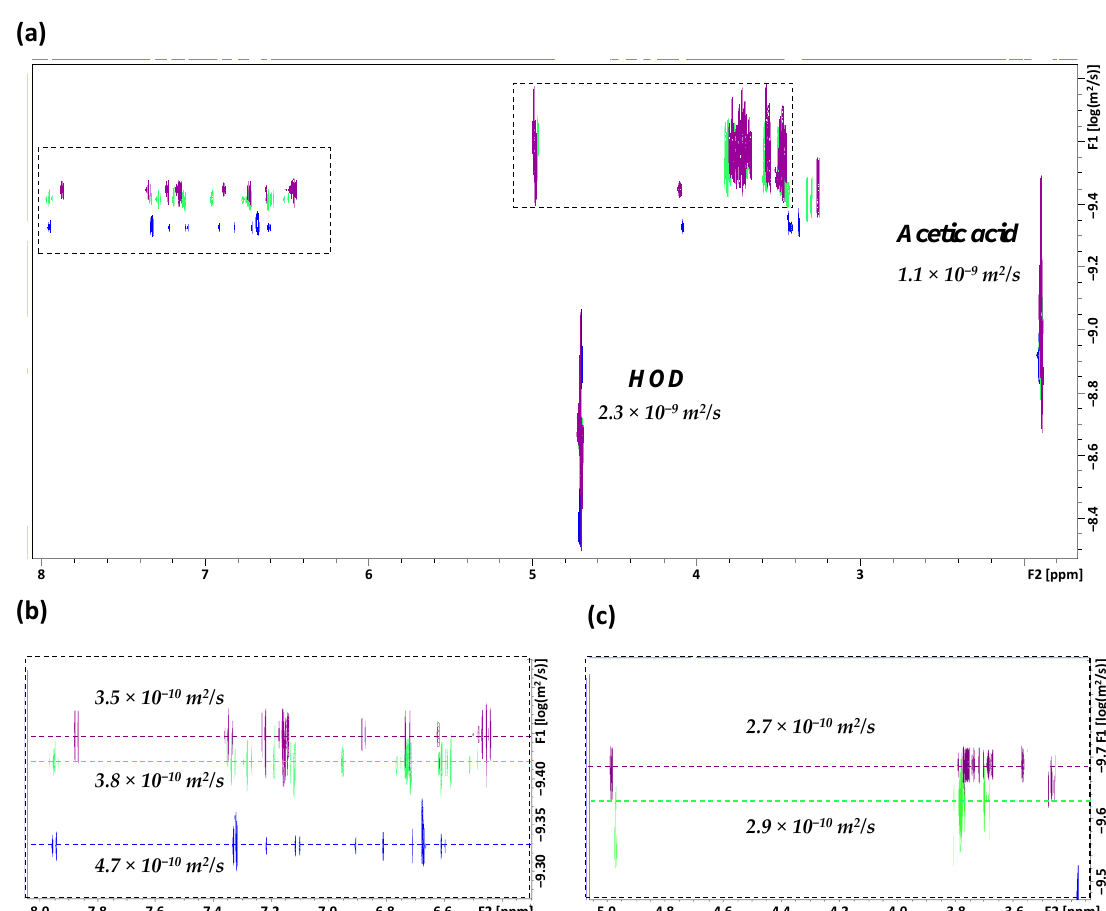
Figure 7. ( a ) Overlay of full range 2D DOSY experiments (600 MHz, 298 K) of carvedilol (5 mM) in the absence of CDs ( ) or in the presence of an equimolar concentration of βCD ( ) or γCD ( ), as measured in 0.1 M acetate-buffered D 2 O (pH = pKa = 4.7); ( b ) the expanded aromatic moiety region of carvedilol; ( c ) the expanded region of CDs.